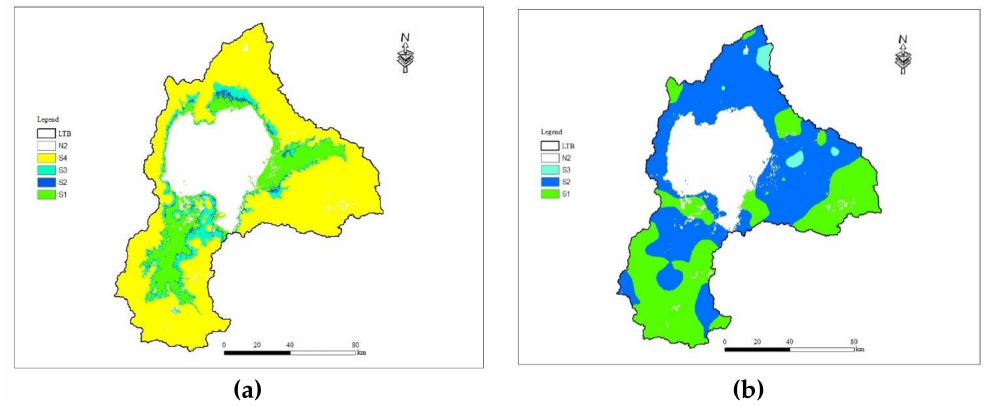
Figure 7. Reclassified factors ( a ) groundwater depth; and ( b ) groundwater salinity.